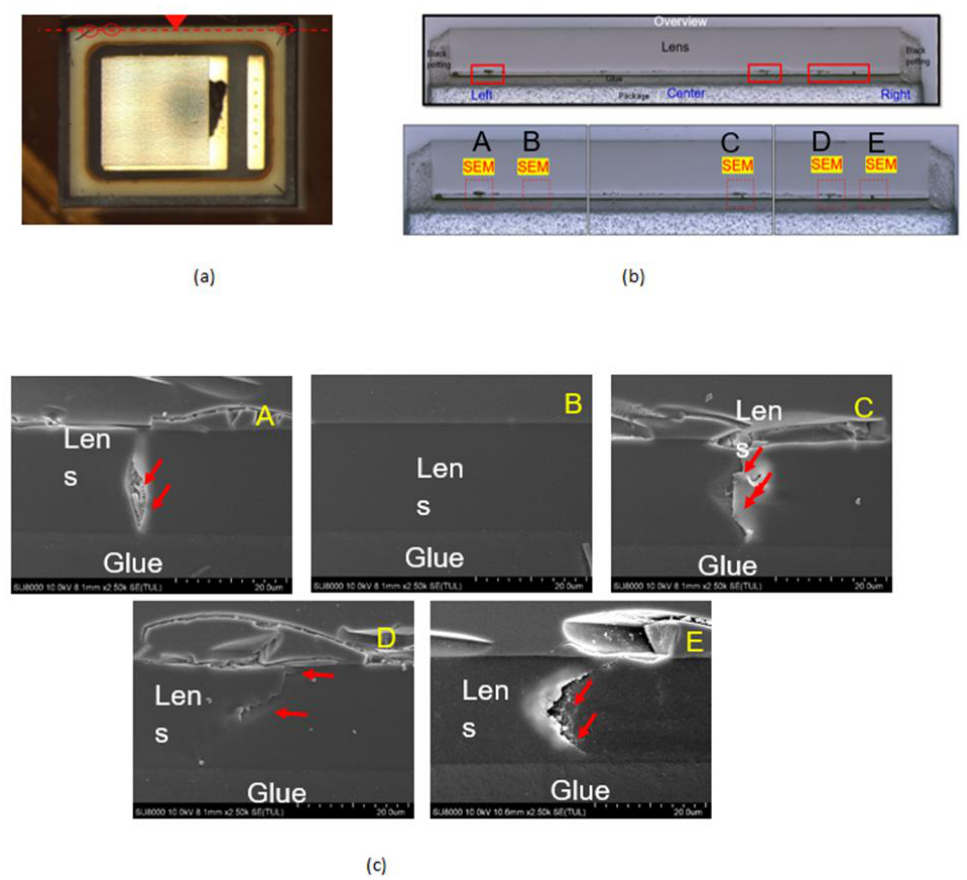
Figure 3. ( a ) Top view optical image of the cracked lens unit of VCSEL; ( b ) cross section view optical images of cracks observed in different positions labeled A–E; and ( c ) SEM images of respective positions.